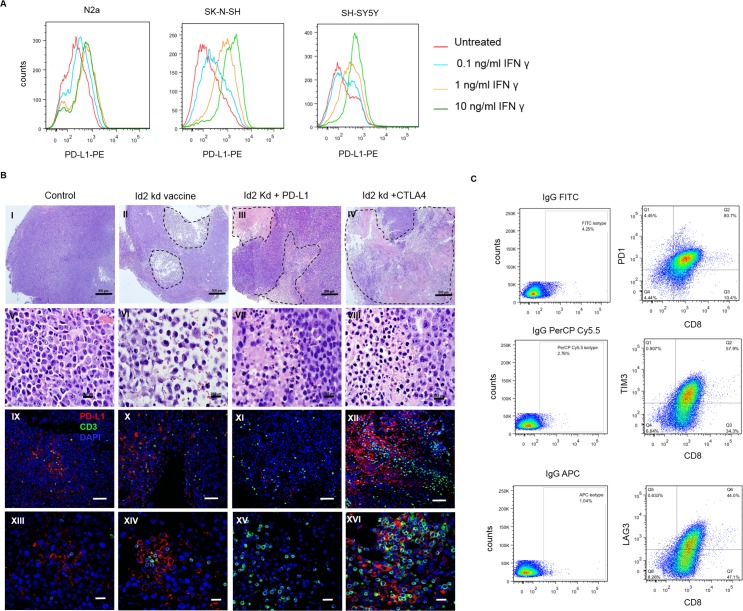
Programmed cell death-ligand 1 (PD-L1) is expressed on both mouse and human neuroblastoma cell lines and is up-regulated following 24-hour interferon gamma (IFNγ) exposure.(A) PD-L1 expression on the surface of mouse Neuro2a was analyzed by flow cytometry and is up-regulated in a dose-dependent manner (mean fluorescent intensity [MFI]). The expression of PD-L1 on human neuroblastoma cell lines SY5Y and SK-N-SH (non-NMYC amplified) had similar changes with exposure to IFNγ. (B) CD3 and PD-L1 expression in mouse neuroblastoma tumors following receipt of Id2kd vaccine with or without checkpoint blockade therapy. Representative tumors were dissected from naïve mice (I, V, IX, and XIII) and from mice after receipt of Id2kd vaccine (II, VI, X, and XIV), Id2kd plus PD-L1 antibody (III, VII, XI, and XV), and Id2kd plus CTLA-4 antibody (IV, VIII, XII, and XVI). Hematoxylin and eosin (H&E) staining (I–VIII) and immunofluorescence double staining (IX–XVI) for CD3 (green) and PD-L1 (red) were performed. The nuclei were stained with DAPI (blue). Representative micrographs from each cohort are shown. Areas of necrotic tissues are marked with black broken lines and coincide with areas of inflammatory cell infiltrates. Panel 1 (I–IV) and panel 3 (IX–XII) are 40× and 100× original magnification, respectively. The scale bar for (I–IV) is 500 μm and for (IX–XII) is 100 μm. The enlarged images in panel 2 (V–VIII) and panel 4 (XIII–XVI) are of 600× original magnification. The scale bar is 20 μm. (C) Expression of activation markers on the surface of CD8+ tumor-infiltrating lymphocytes isolated from shrinking tumors of mice treated with α-CTLA-4 plus Id2kd vaccine. Programmed cell death 1 (PD1), TIM3, and LAG3 were expressed on tumor-infiltrating lymphocytes (TILs) by flow cytometry compared with isotype controls. APC, antigen-presenting cell; FITC, fluorescein isothiocyanate; IgG, immunoglobulin G; PerCP, peridinin-chlorophyll-protein complex.